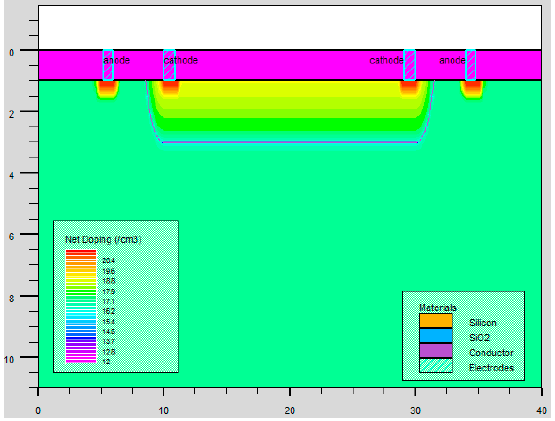
Figure 5. Two-dimensional structure of the photodiode.